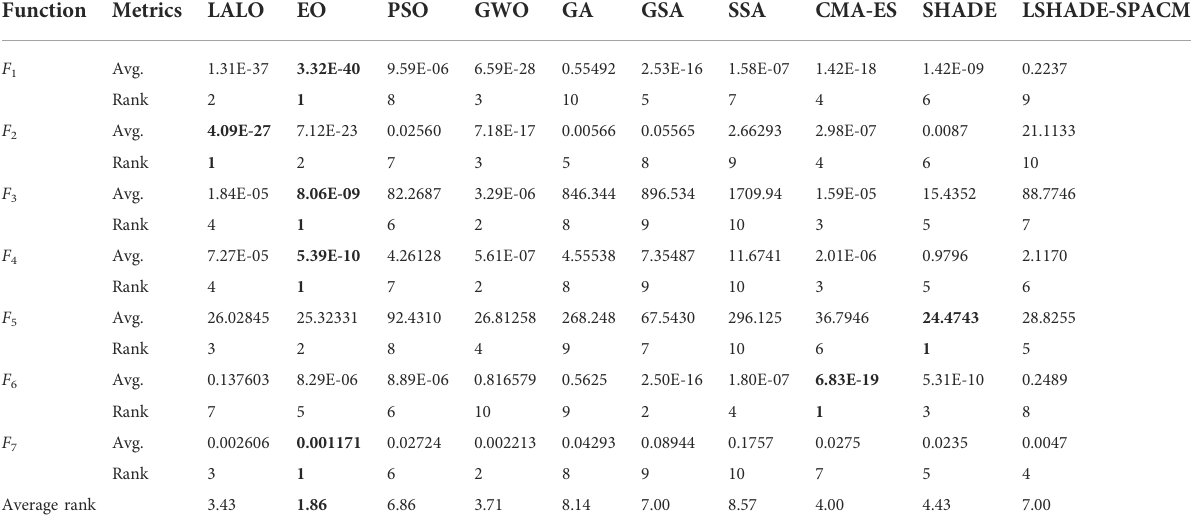
EO: Equilibrium optimizer; PSO: Particle Swarm Optimization; GWO: Grey wolf optimizer; GA: Genetic algorithm; GSA: Gravitational search algorithm; SSA: Salp swarm algorithm; CMA-ES:Evolutionstrategywithcovariancematrixadaptation;SHADE:Success-HistorybasedAdaptiveDifferentialEvolution;LSHADE-SPACMA:SHADEwithlinearpopulationsize reduction hybridized with semi-parameter adaption of